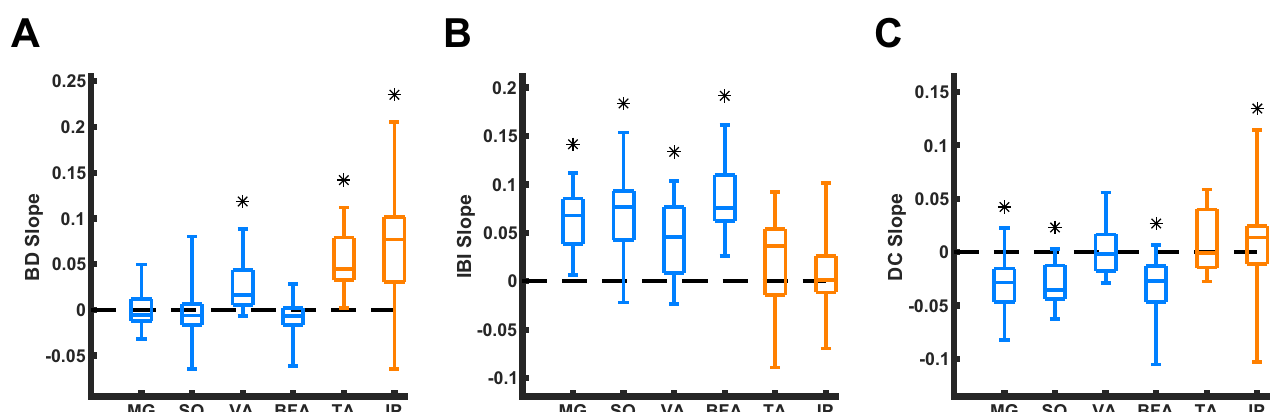
Fig 11. Median and quartile slopes of the linear regression lines relating EMG burst duration (BD), interbust interval (IBI), and duty cycle (DC) with time during paw shaking. Box plots depict the median slopes and quartiles of BD versus burst time (A) , IBI versus burst time (B) , and DC versus burst time (C) for all of the muscles. The dashed lines represent a slope of zero. Black asterisks indicate whether the linear regression slopes are statistically different from zero, with a p-value < 0.05 (the Wilcoxon signed rank test).